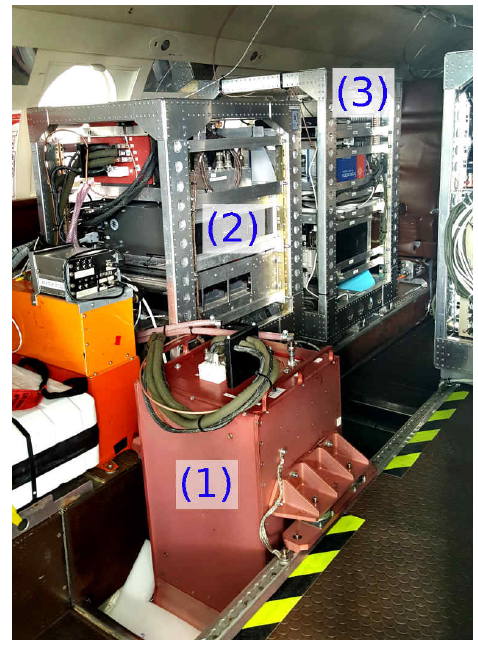
Figure 2. Picture of the 2µmDWL mounted within the Falcon air- craft showing the transceiver unit (1), the power supply and cooling rack (2), and the data acquisition rack